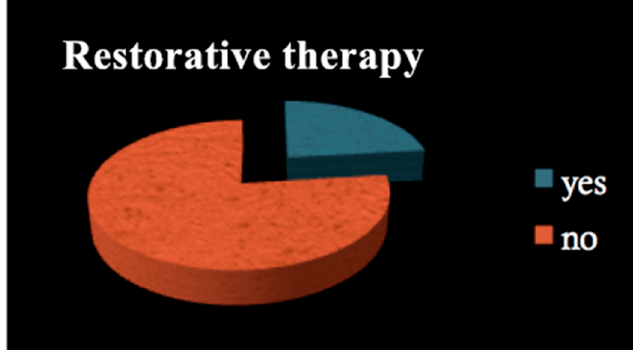
Figure 1. Restorative therapy.